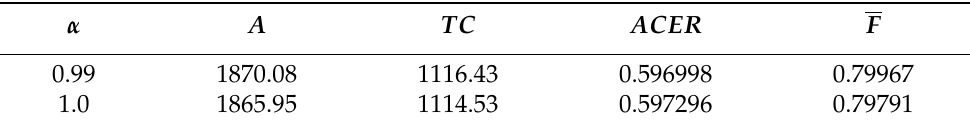
Table 3. Summary of cost-effectiveness measures (13)–(17) for classical ( α = 1) and fractional (0 < α < 1) COVID-19 disease optimal control problems. Parameters according to Table 1 and C 1 = C 2 = 1 in (16).